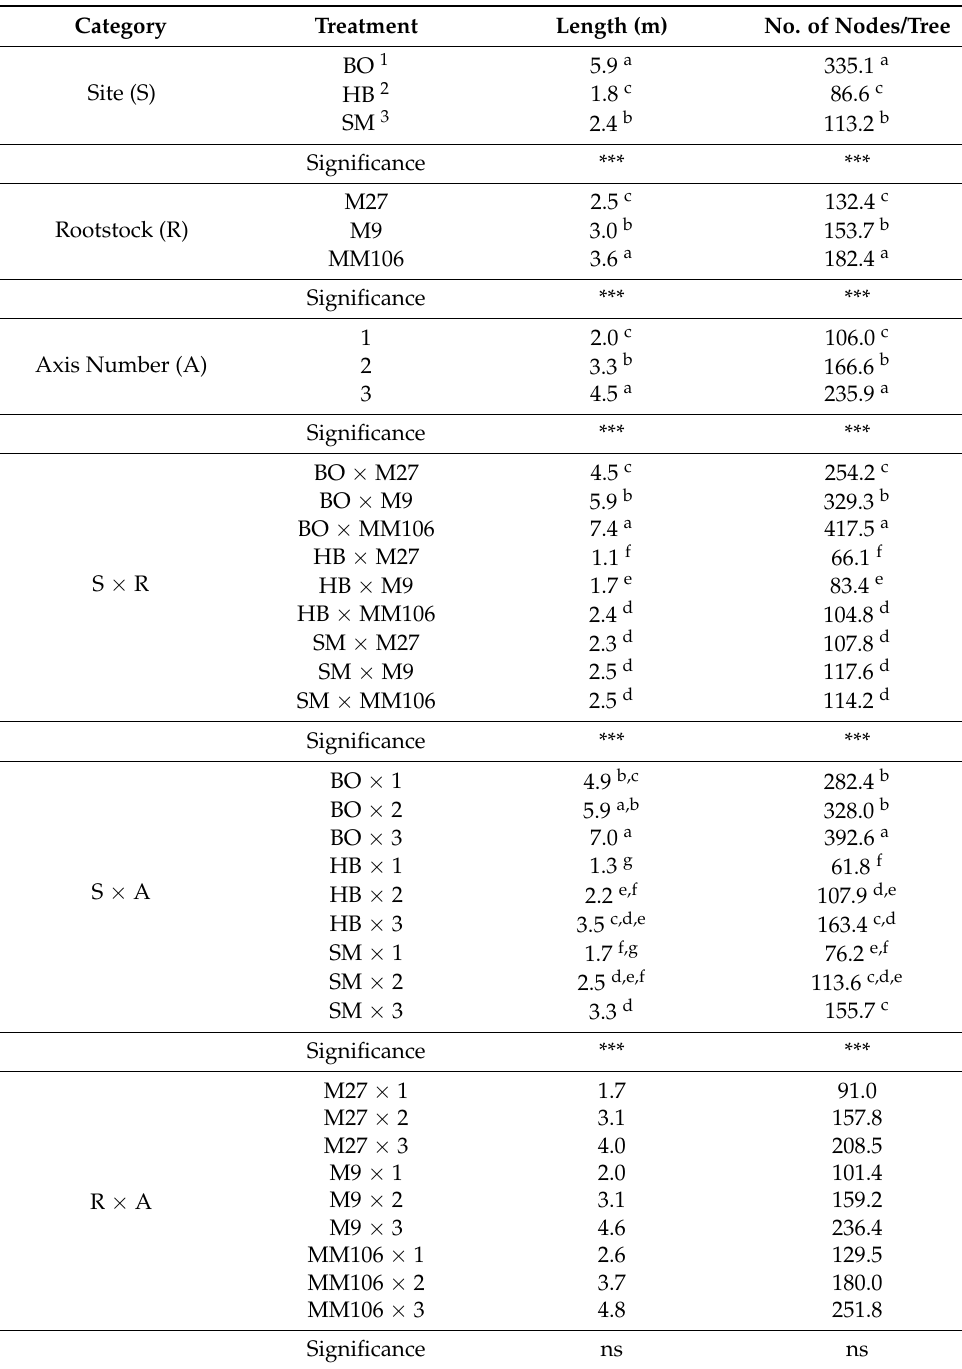
Table 7. Main effects of site of cultivation, rootstock, axis number, and their interactions on total tree growth in ‘Fuji’